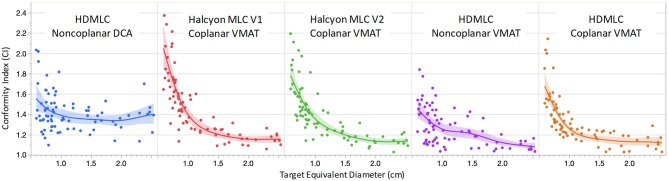
Comparison of conformity index (CI) as a function of target equivalent diameters for five planning and delivery techniques. Dots are the actual CI for an individual target. Solid lines are fitting lines using spline model and the shaded areas are 95% confidence interval of fit.